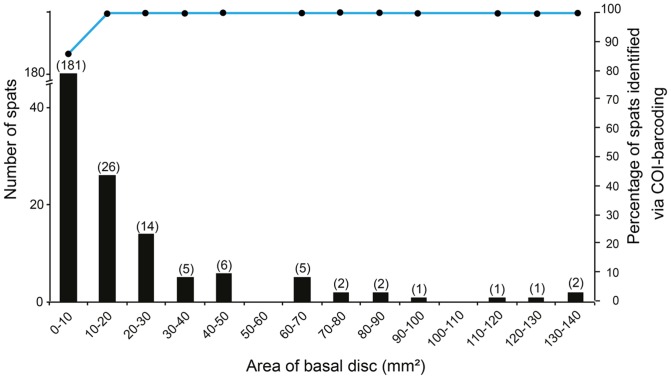
Efficiency of COI barcoding on spats of different sizes.All sizes found in this study were successfully identified with COI barcoding, except those <10 mm2, which had an 86.7% (157/181) identification rate. The bar chart represents the number of spats and the dot with blue line represents the identification rates for different sizes.